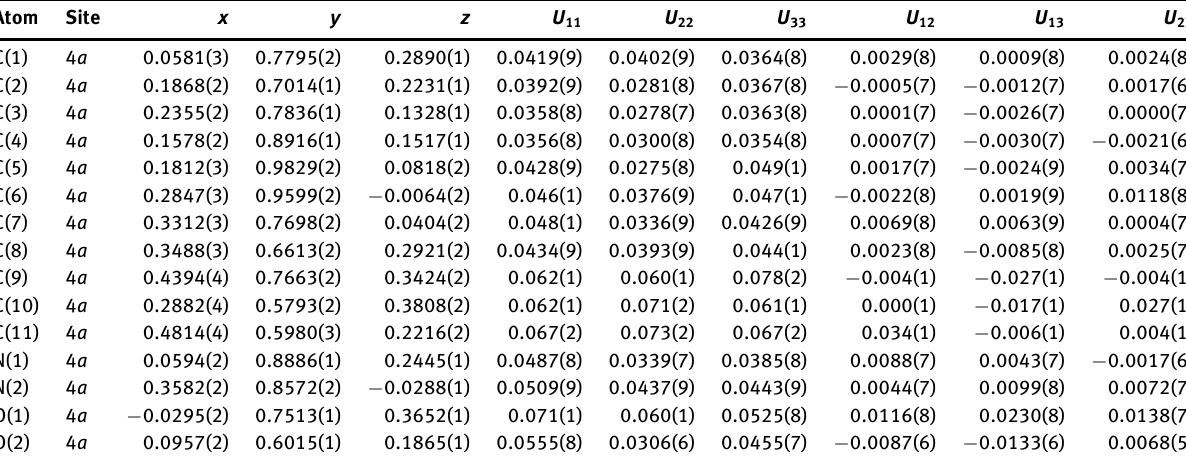
Table 3: Fractional atomic coordinate and displacement parameters (Å 2